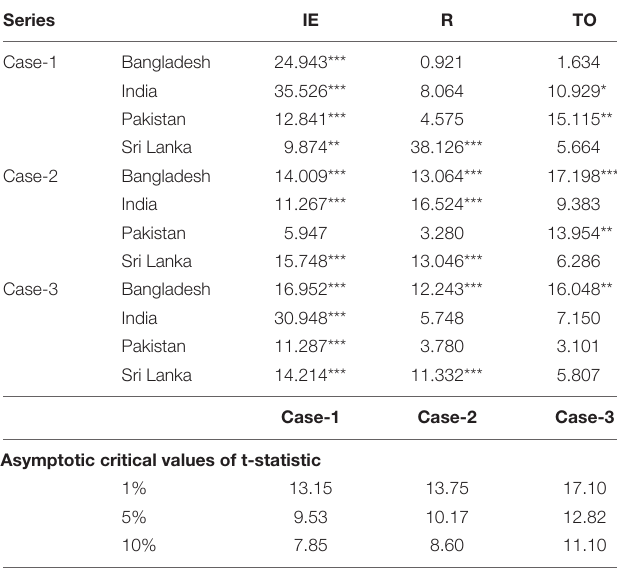
TABLE 4 | Results of Kruse non-linear unit root